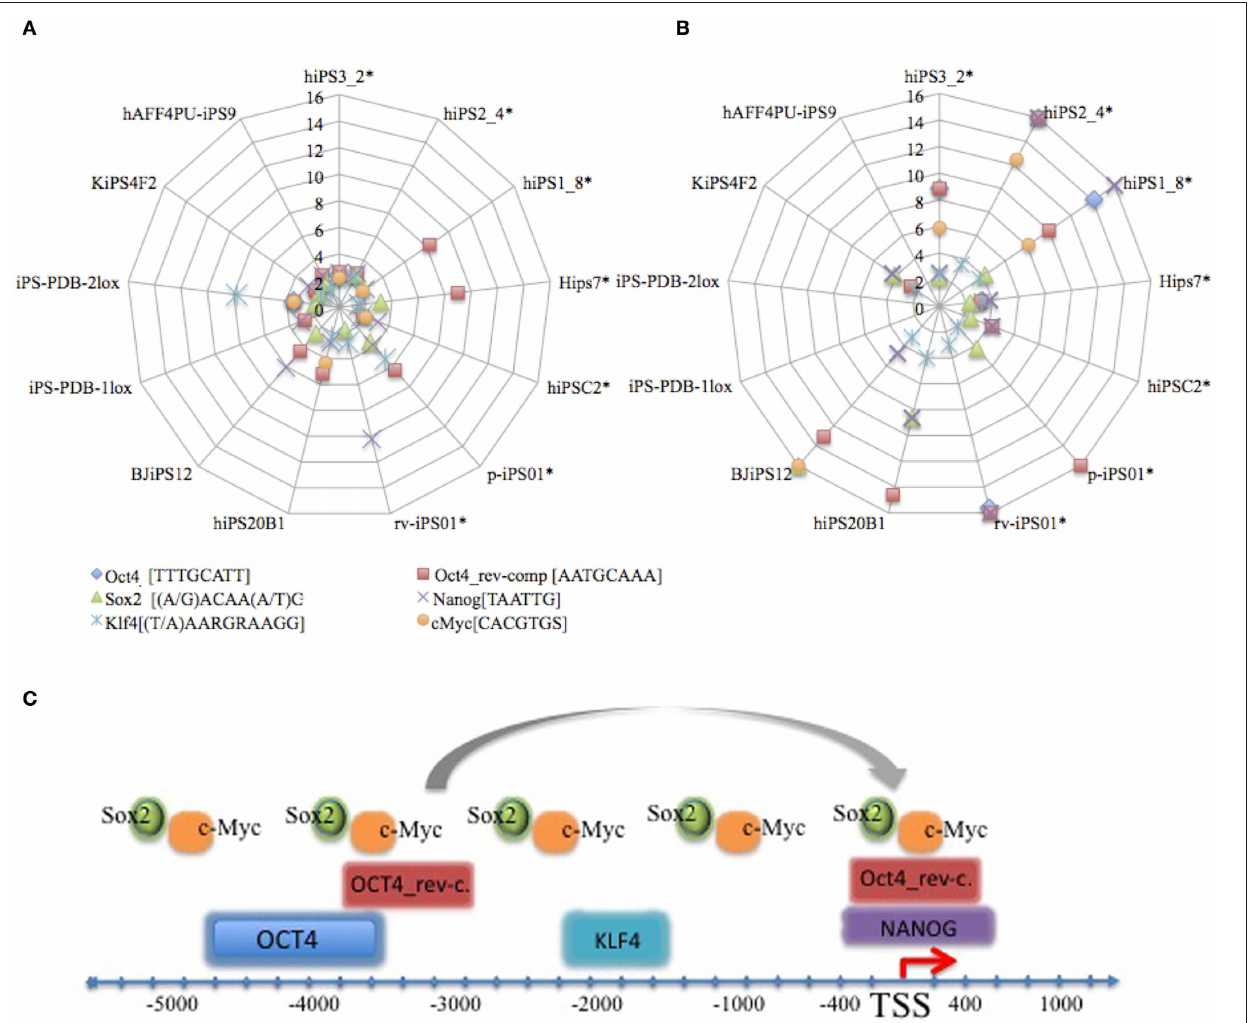
(Materials and Methods). Motifs consensus is shown aside the motif name. Number of genes for each cell line can be referenced from Supplementary Tables 1 and 2. IUPAC symbol R and S connoting A/G and C/G, respectively. Panel (C) represents promoter regulation model based on the allocations of predicted transcription factor binding sites by F-match tool in ExPlain3.0 suite. TSS denotes transcriptional start